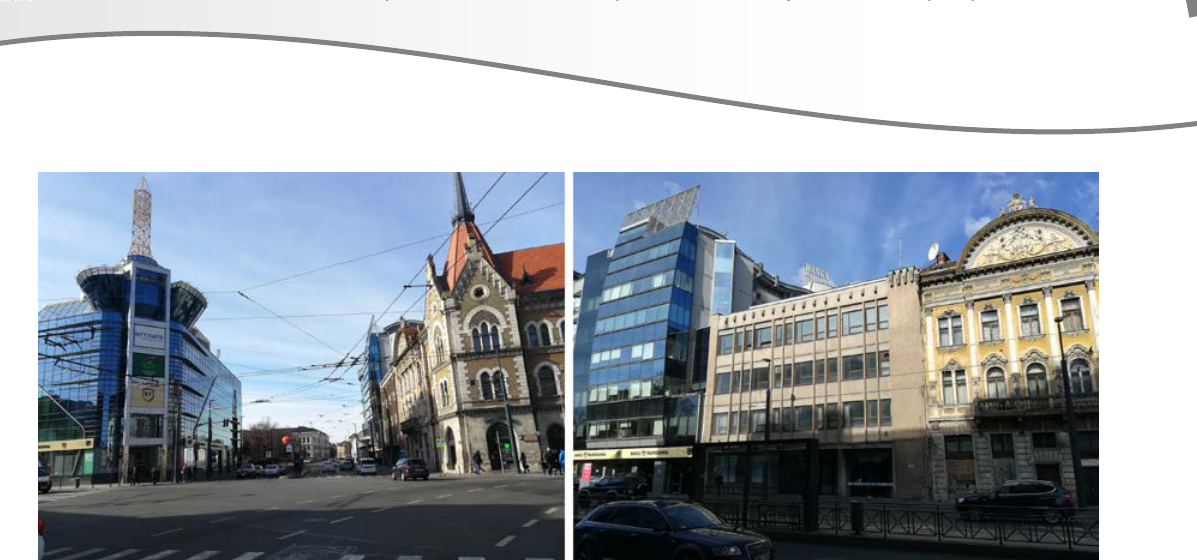
Figure 21: New hybrid cultural landscape in the proximity of Mihai Viteazul Square Source: Alexandru- Sabin NICULA, 2019©